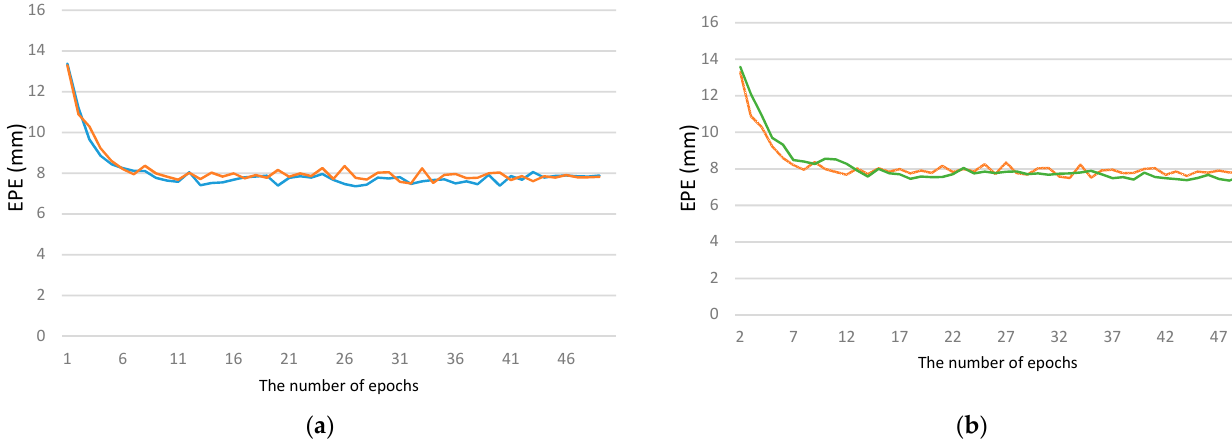
Figure 7. Convergence comparison of InterNet+ and InterNet on the STB dataset. The blue and orange lines in ( a ) are the two complete trainings process of the original InterNet under the same conditions. It can be observed that the training effect has a large randomness in the early stage and stabilizes after 45 epochs. The green line in ( b ) is the training method we used, and it can be seen that the overall convergence fluctuates regularly with the change in the learning rate. After 25 epochs, it is basically stabilized.